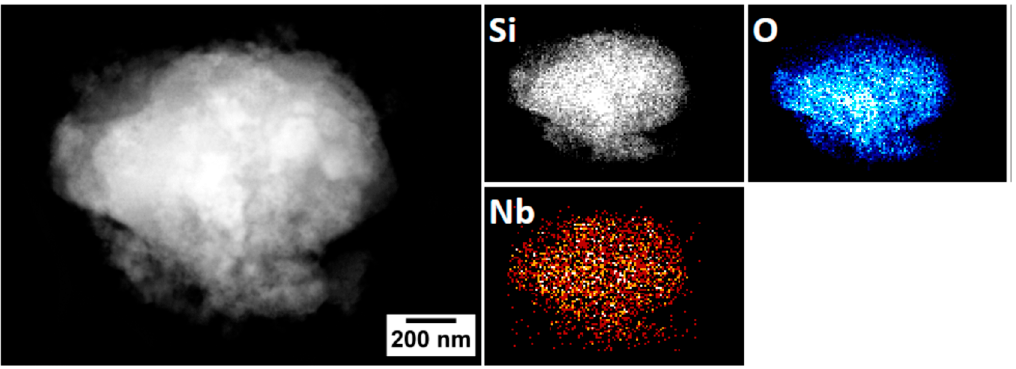
Figure 2. Representative HAADF-STEM micrograph of a NbO x -SiO 2 grain and corresponding EDS element mapping.